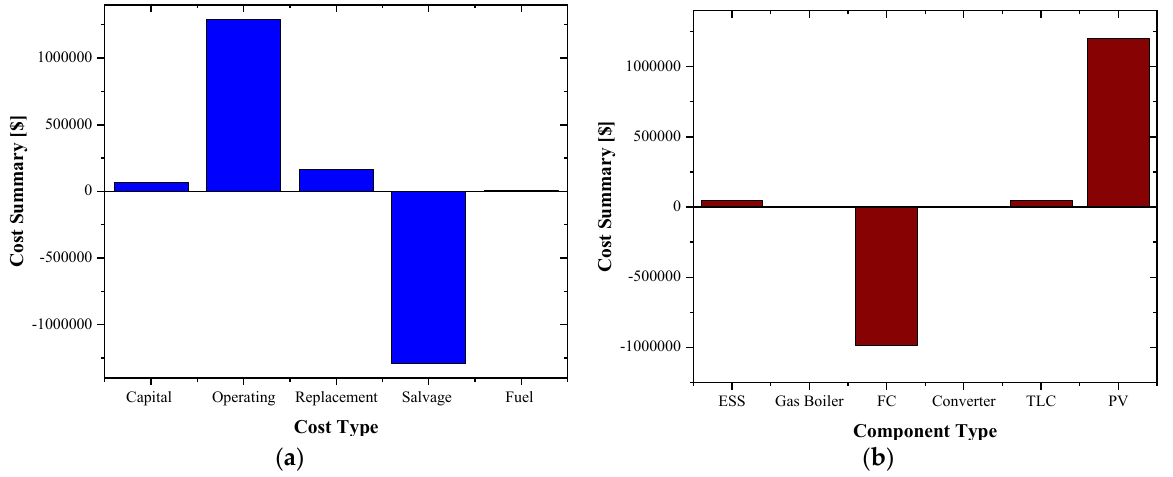
Figure 8. Summary of the system costs based on: ( a ) type of the cost; ( b ) type of the component.